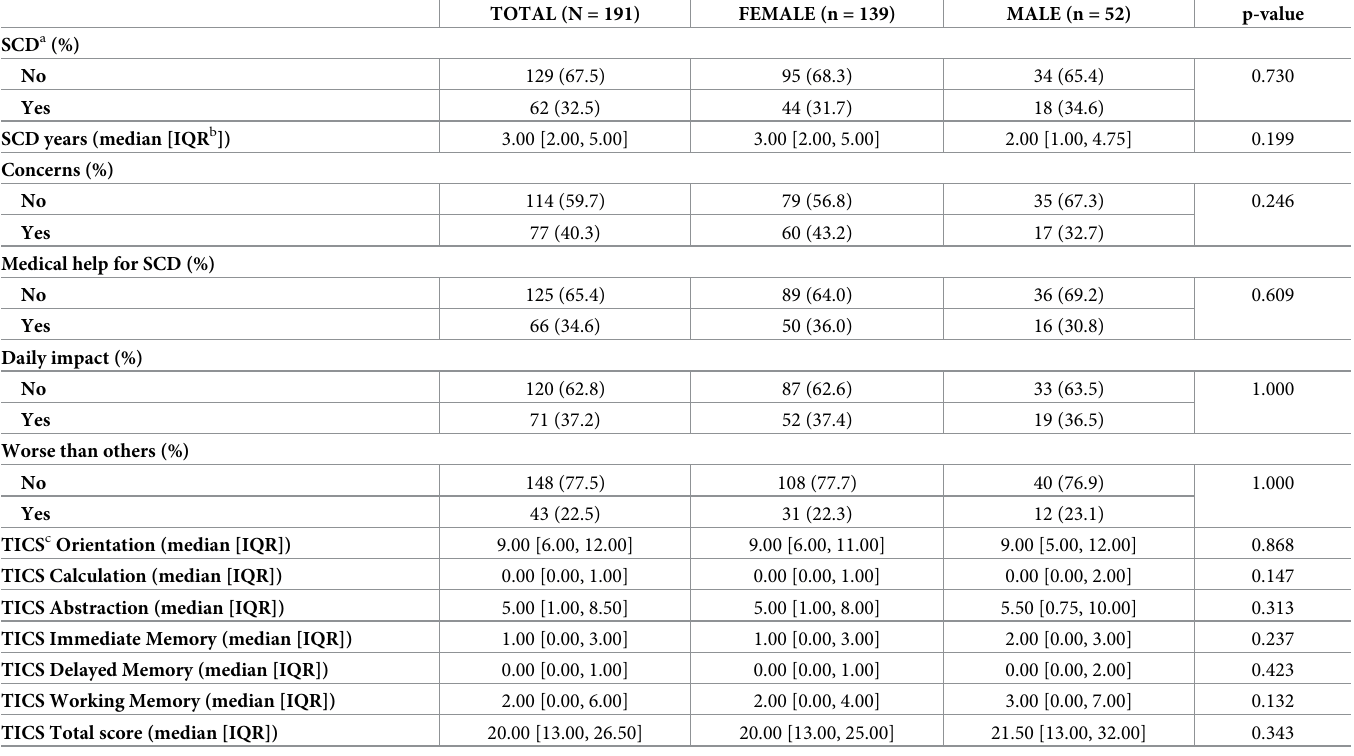
Table 3. Subjective and objective cognitive status of the